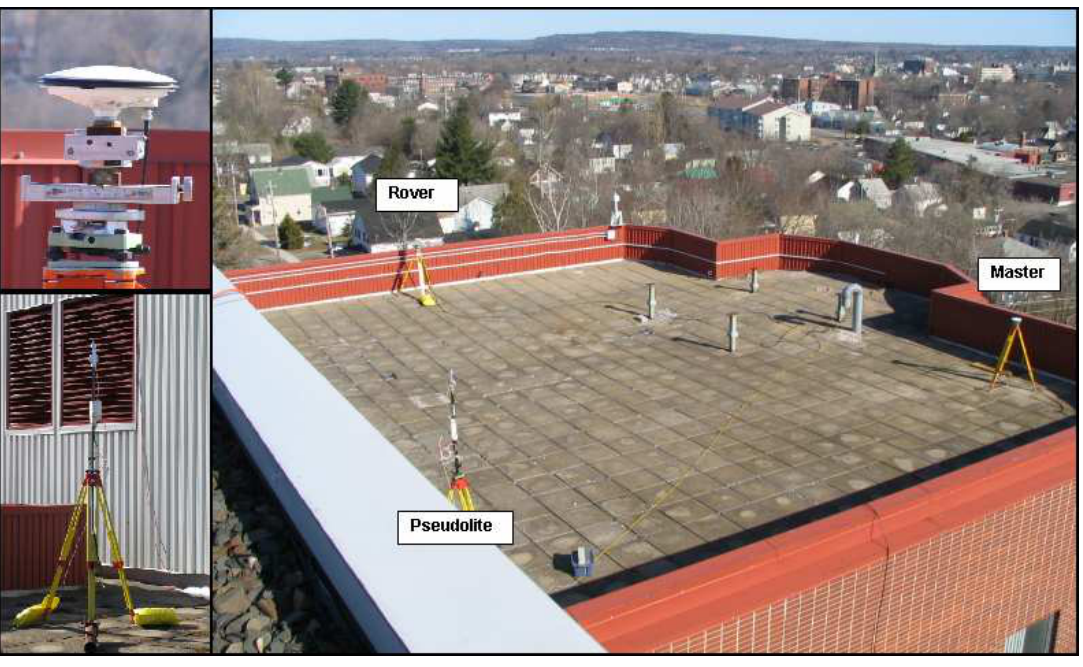
Figure 12. Displacement Detection Experiment Configuration (Top Left: Rover Antenna on Translation Stage, Bottom Left: IN200 Pseudolite, Right: Observed